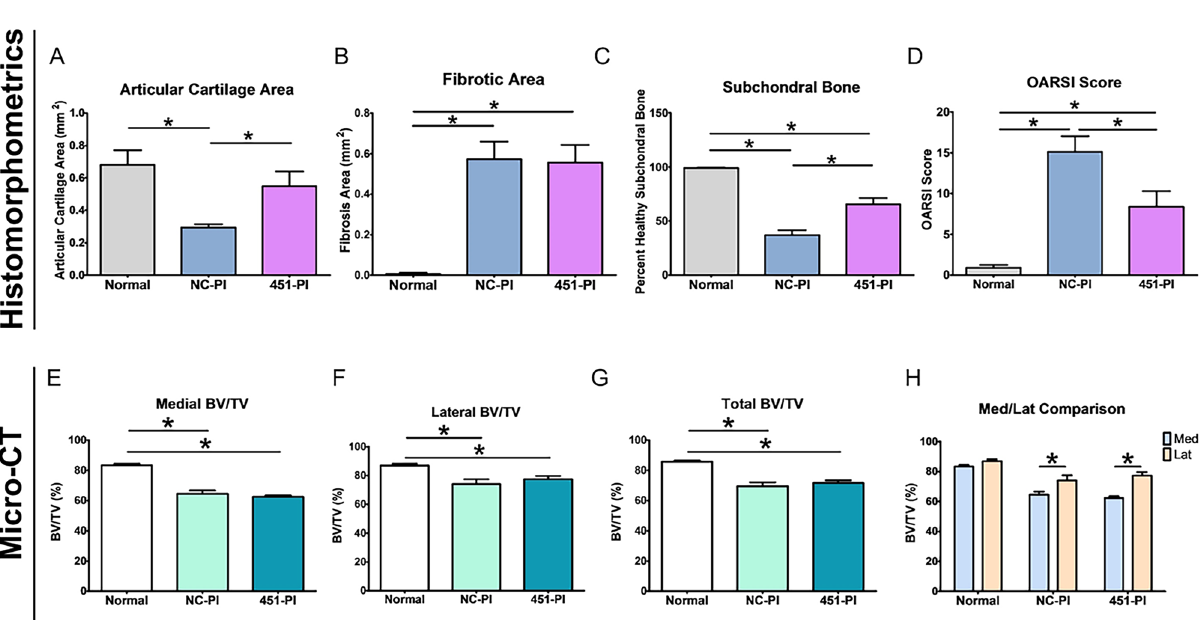
Figure 3. Prophylactic administration of 451-PI decreases OA severity. Histomorphometric analysis of articular cartilage area ( A ), fibrotic area ( B ), percent healthy subchondral bone ( C ), and OARSI scoring ( D ). Micro-CT bone volume/total volume (BV/TV) analysis of medial femurs ( E ), lateral femurs ( F ), total (medial + lateral, G ), and the comparison of medial and lateral femurs ( H ). An asterisk indicates statistical significance using an alpha equal to